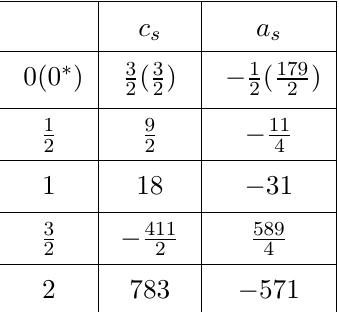
Table 4 . Coe(cid:14)cients of the conformal anomaly in [39]. The entry labeled 0 (cid:3) give the result for two-form (cid:12)eld; it gives the same contribution to c 0 as the scalars, but its contribution to the a 0 coe(cid:14)cient is